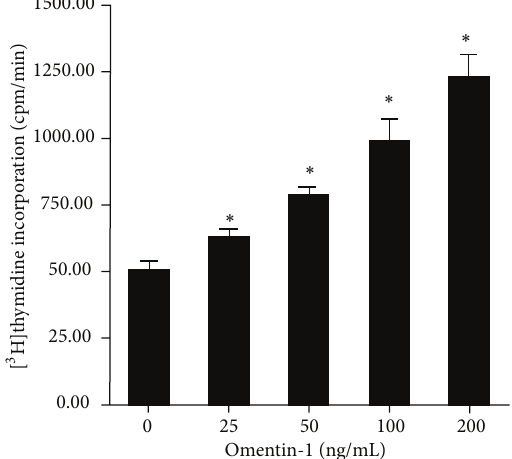
Figure 1: Omentin-1 stimulated the proliferation of hOB. Cells were exposed to 25–200 ng/mL omentin-1 for 48h. Cell proliferation was determined by measuring [ 3 H]thymidine incorporation. Results are expressed as counts per minute. ∗ 𝑃 < 0.05 versus